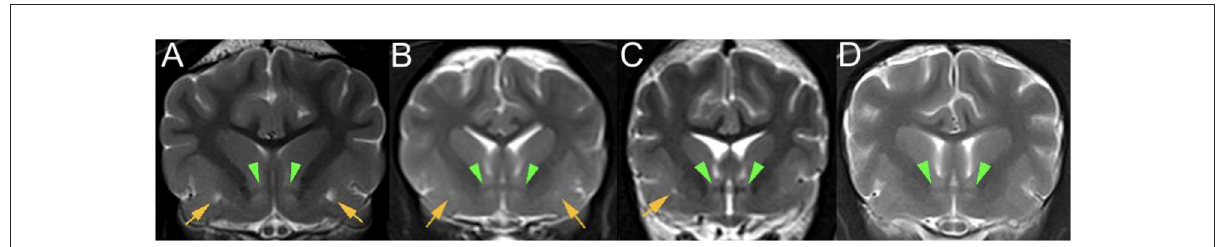
FIGURE2 T2-W (3 Tesla) transverse plane images of various dog brains at the level of the rostral commissure (green arrowheads) presenting: (A) bilaterally symmetrical, strong focal T2 hyperintensities (yellow arrows) within the ventral forebrain; (B) bilaterally symmetrical, faint focal T2 hyperintensities (yellow arrows) within the ventral forebrain; (C) unilateral right-sided, strong focal T2 hyperintensity (yellow arrow) within the ventral forebrain; (D) control group without CSF-isointense foci in the ventral forebrain at either side of the rostral